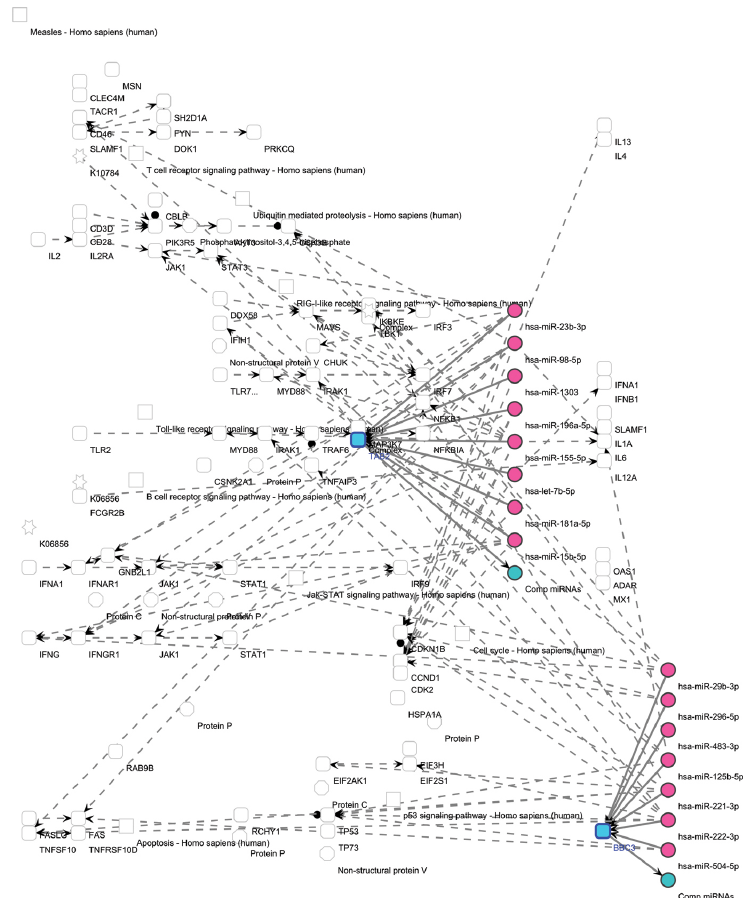
Figure 5: The blue squares represent TAB2 and BCC3 while the two miRNAs predicted from these two genes are marked green. The network has been reduced to only include the most relevant nodes.